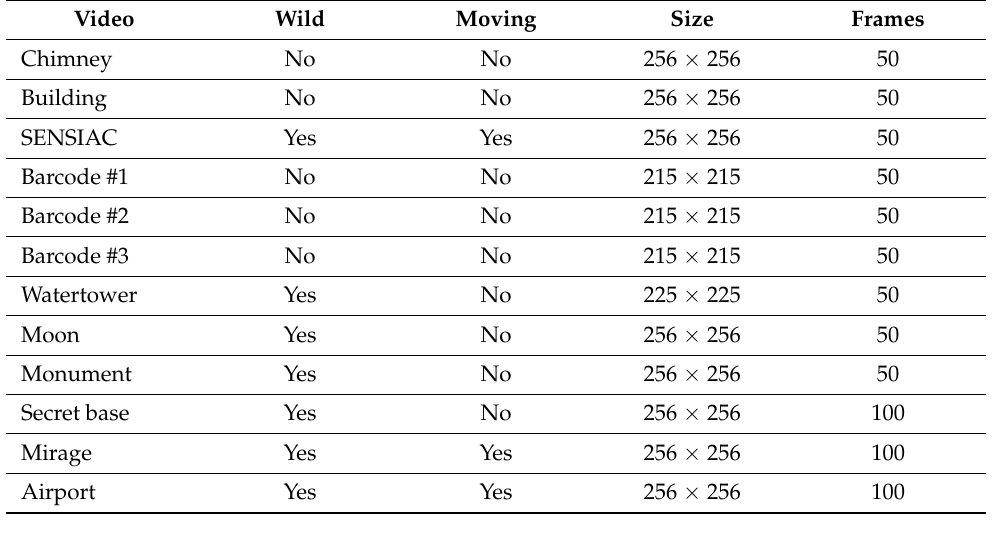
Table 1. Summary of video datasets used in experiments. “Wild” means that a video was taken from an actual scene.